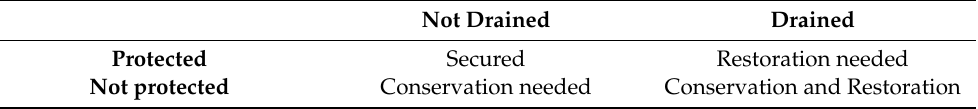
Table 1. Criteria used to determine priority actions for peatland re-wetting. We define this selection as a priority to reduce the peatland protection gaps in terms of both quality and quantity and thus their function to provide a greater range of ecosystem services within the hotspots of the cluster